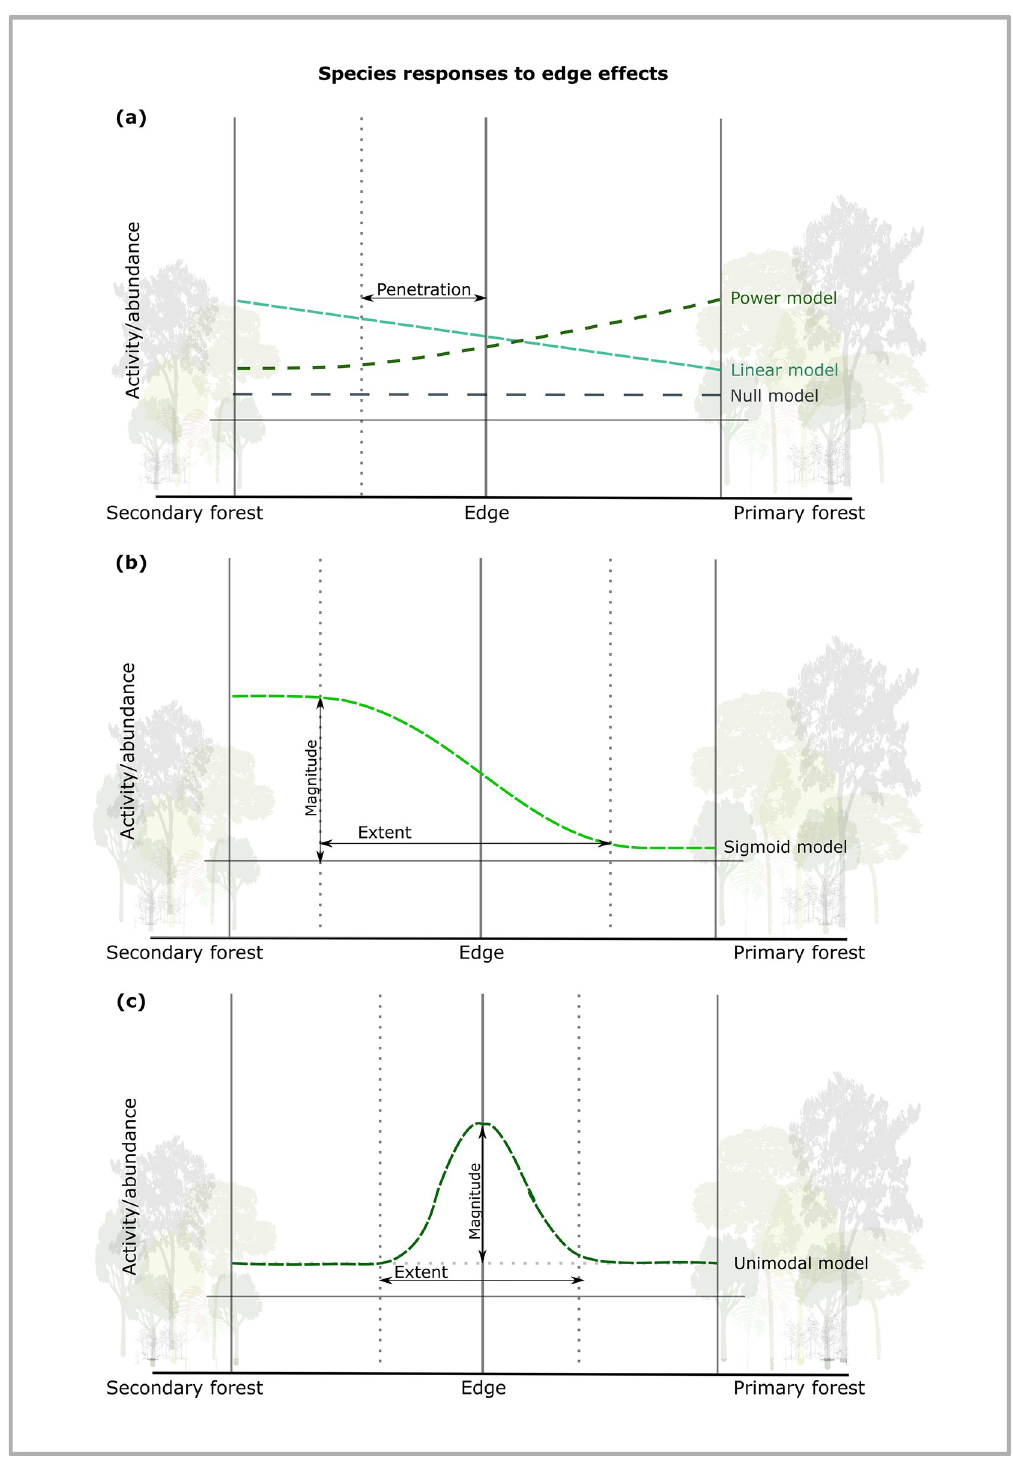
Fig 2. Visual representation of the five models proposed by Ewers & Didham [19] to delineate species’ theoretical responses to edge effects. (a) For the null, linear, and power models it is not possible to calculate extent or magnitude as there is either no response present or the response exceeds the sampling area; (b) in the sigmoid model, species exhibit a negative response to edge effects and asymptotes are reached in each habitat; and (c) in the unimodal model, species demonstrate a preference for edge habitat. Note, we have illustrated here a hypothetical preference for secondary forest using the linear